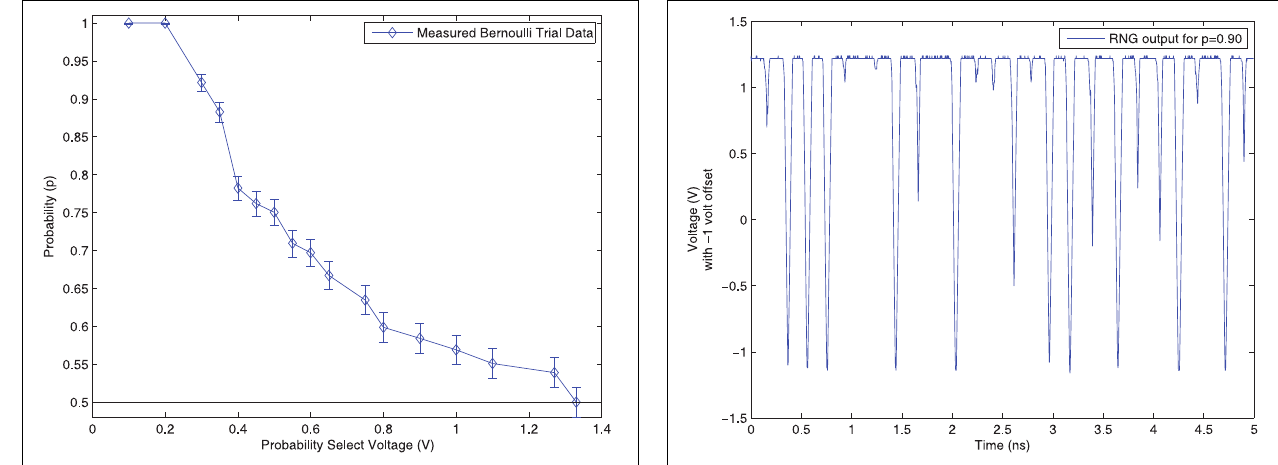
FIGURE 11 | Voltage output from Dynamic Bernoulli Probability Circuit also called a random number generator (RNG) circuit as labeled in the graph, corresponding to the output out of the third (final) OTA circuit from Figure 3. A 1 volt offset was arbitrarily chosen for the comparator, but other voltage offset values than this were anecdotally observed to have undesired noise effects resulting in spurious switching at the output of the comparator. The noise amplifiers, and thus comparators, were observed to switch at approximately 208 ps as a maximum rate, thus independent Bernoulli variables could be produced at most at this time period in this particular device. A digital “1” is produced with probability p = 0 . 90 and “0” with 1 − p = 0 . 10. When the voltage is above the threshold V out > V dd − V ss 2 it is considered a digital “1” and otherwise a “0,” where the threshold happens to be 0 volts in this case. The samples in this circuit change much faster than can be consumed, and thus random samples are taken from the output of this circuit at a slower rate than the rate at which it changes state, but preserving